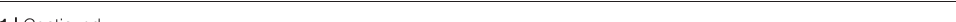
FIGURE 1 | Continued H. hepaticus strain 3B1 (CdtB) or the CdtB of H. hepaticus strain 3B1 with the H265L mutation (CdtB-H265L). HT-29 (A) and Hep3B (B) cells were then processed for fluorescent staining with fluorescent labeled-phalloidin to detect F-actin (infrared), DAPI to counterstain the nucleus (blue) and primary polyclonal antibodies generated against the p65 subunit of the nuclear factor-kappa B (NF- κ B) associated with fluorescent labeled-secondary antibodies (green). Fluorescent stainings were observed using traditional widefield fluorescence imaging as previously reported (Péré-Védrenne et al., 2016). Analysis of DNA contents of HT-29 (C) and Hep3B (D) cells. Cells were fixed and labeled with propidium iodide and analyzed by flow cytometry. Data represent one representative experiment (performed in triplicate) out of